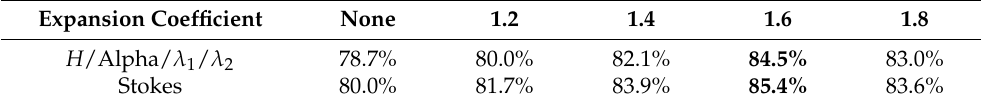
Table 10. MIoU value of different inhibition